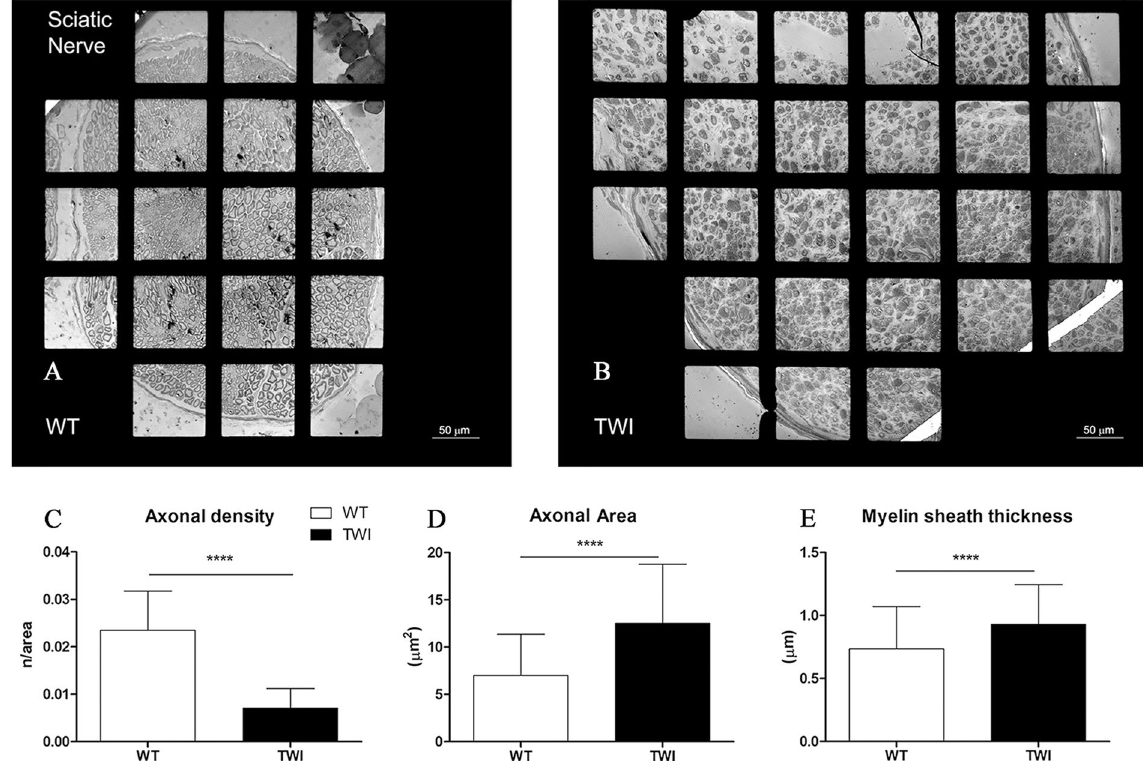
Figure 1. Qualitative and quantitative characterization of P30 sciatic nerves. ( A,B ) Representative micrograph of WT vs TWI sciatic nerve. The total size of sciatic nerve is increased in TWI samples. ( C ) Evaluation of axonal density (number of axons/axonal area). ( D,E ) Morphometric evaluation of axonal